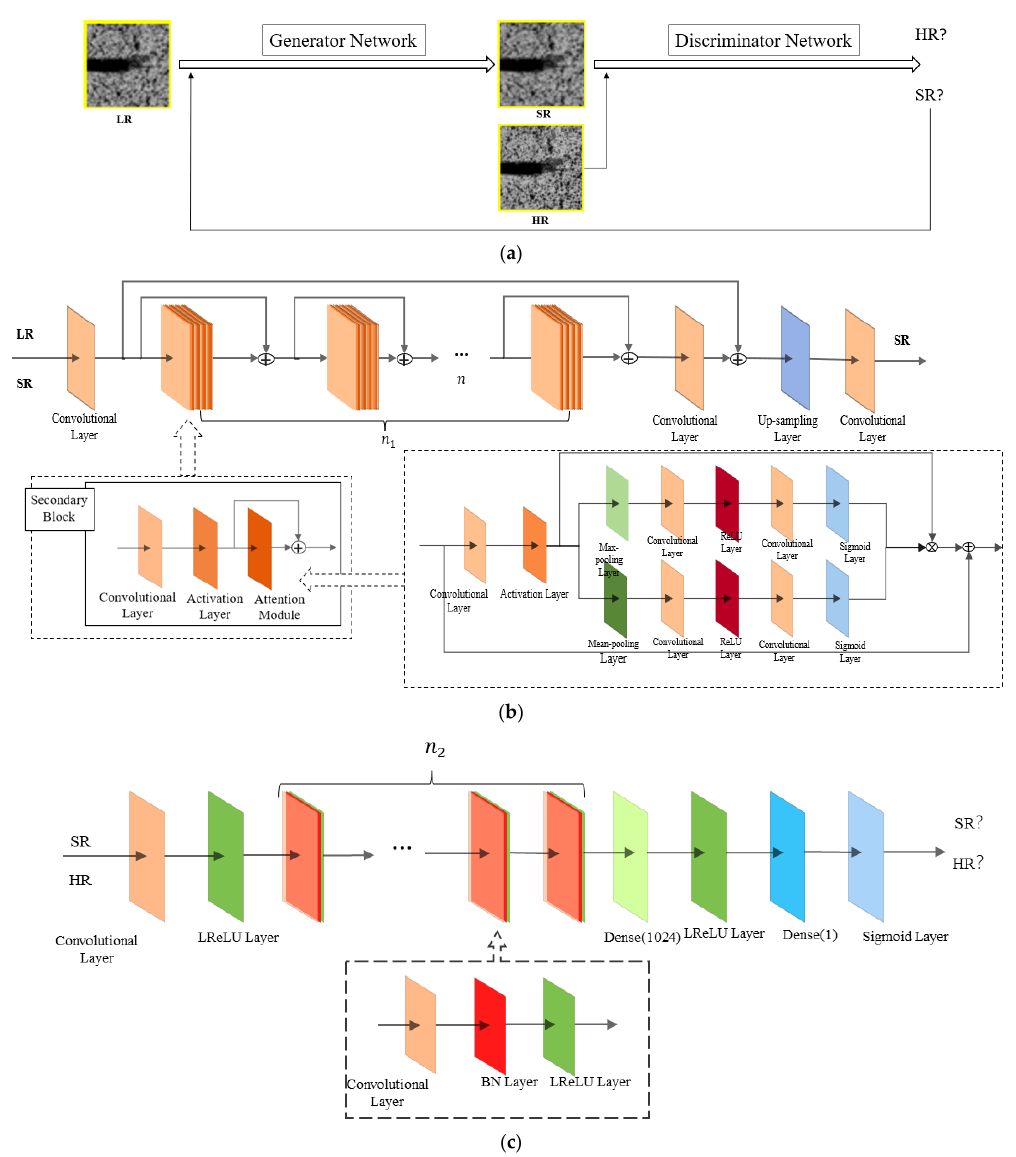
Figure 4. Network structure of ADRAGAN. ( a ) Whole framework; ( b ) generator network ; ( c ) d is- Figure criminator network.